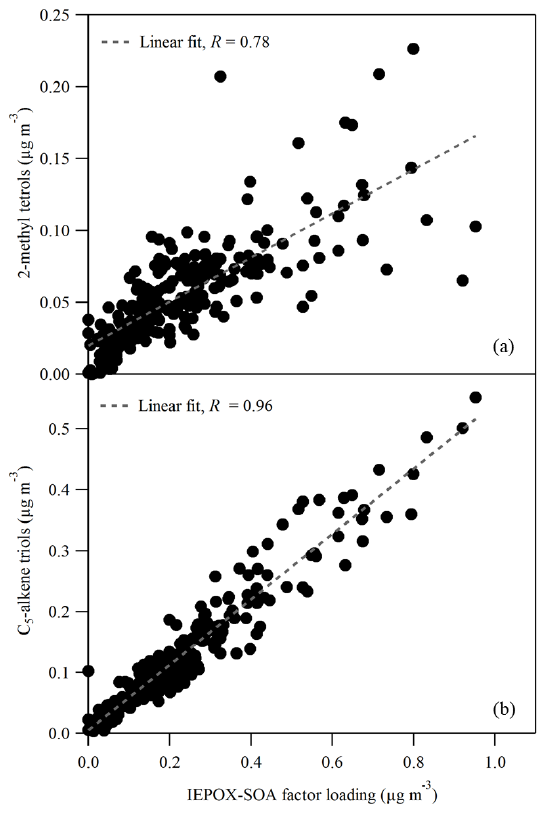
Figure 2. Scatter plot of the loading of the IEPOX-SOA factor de- rived from analysis of the AMS data set and the mass concentrations of C 5 -alkene triols and 2-methyltetrols measured by SV-TAG. All data collected during the IOP1 period are included, meaning that the plotted data are not limited to afternoon time periods.